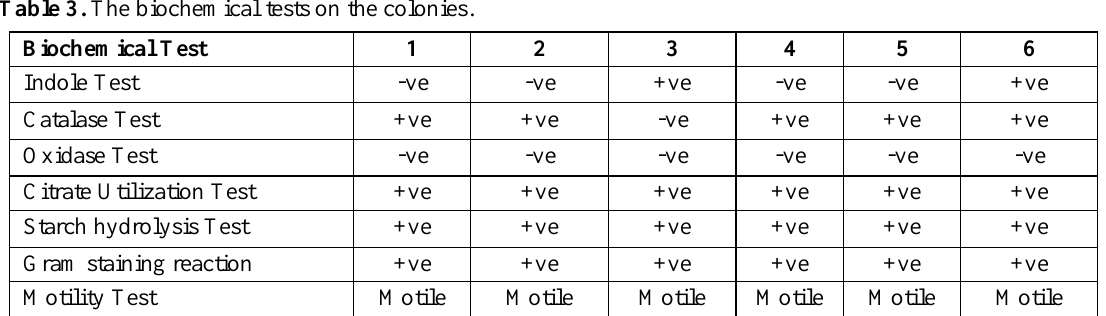
Table 3. The biochemical tests on the colonies.